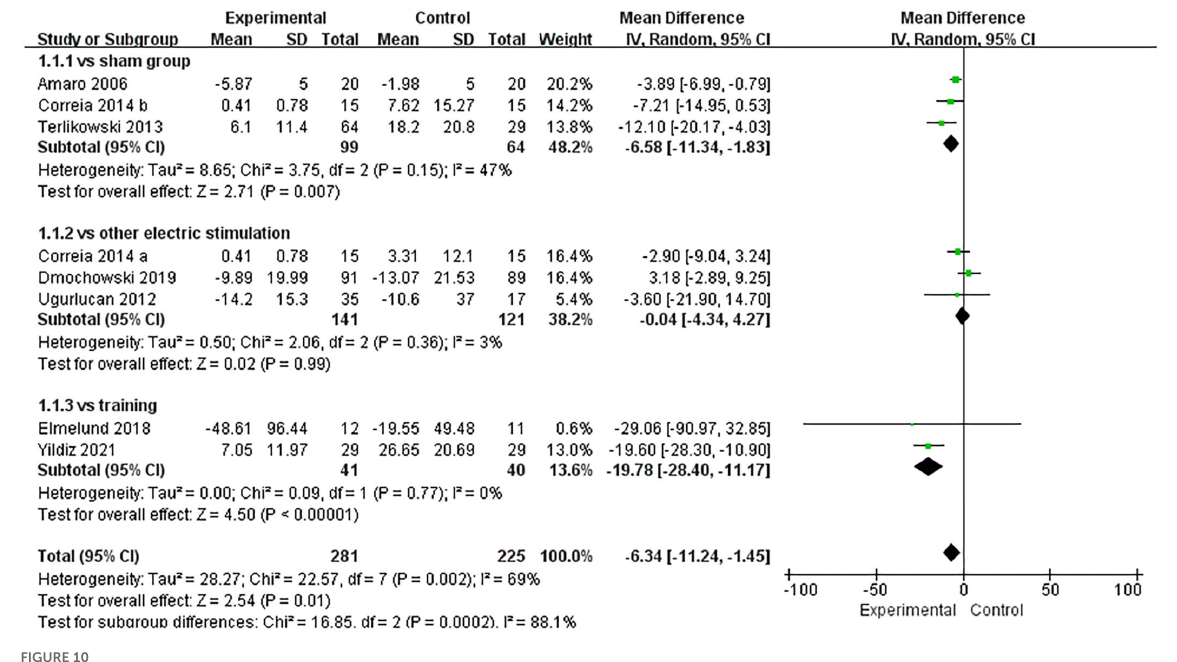
incontinence by transvaginal electrical stimulation of the pudendal